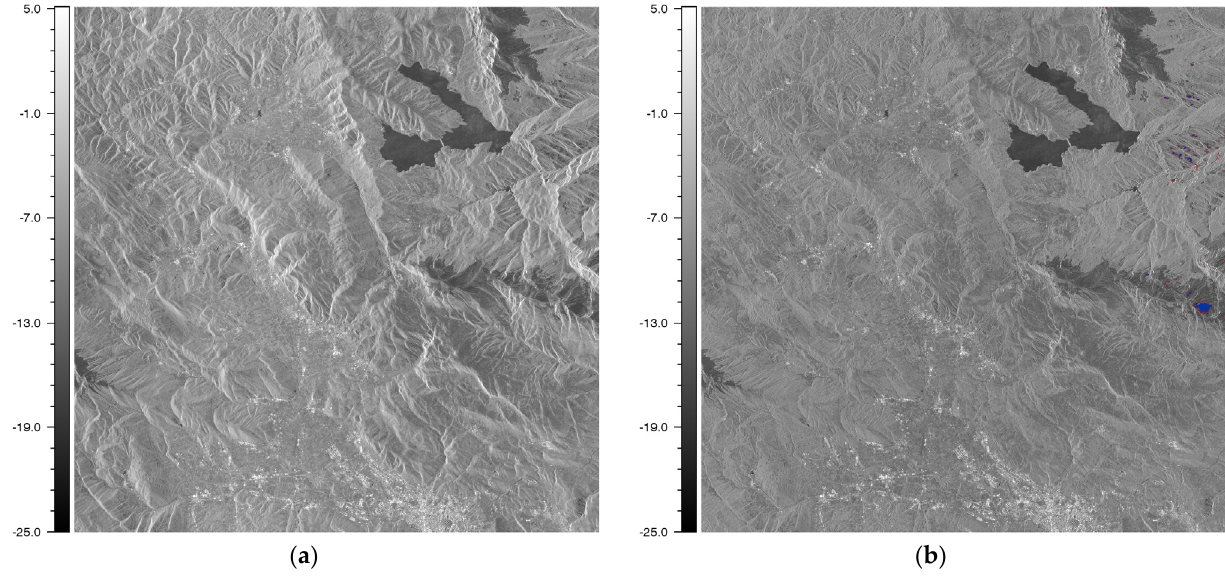
Figure 11. ( a ) (cid:101) σ 0 (dB) image obtained from SAR data without compensation of topography-induced radiometric distortions; ( b ) σ 0 (dB) image obtained from SAR data including the compensation of topography-induced radiometric distortions. A mask identifying (red) layover and (blue) shadow areas is superimposed.